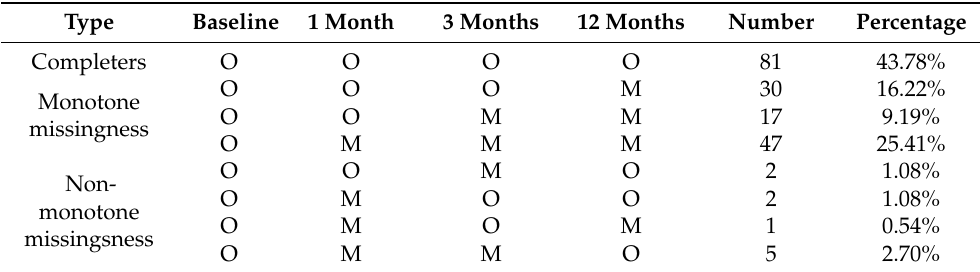
Table 2. Overview of missingness patterns.